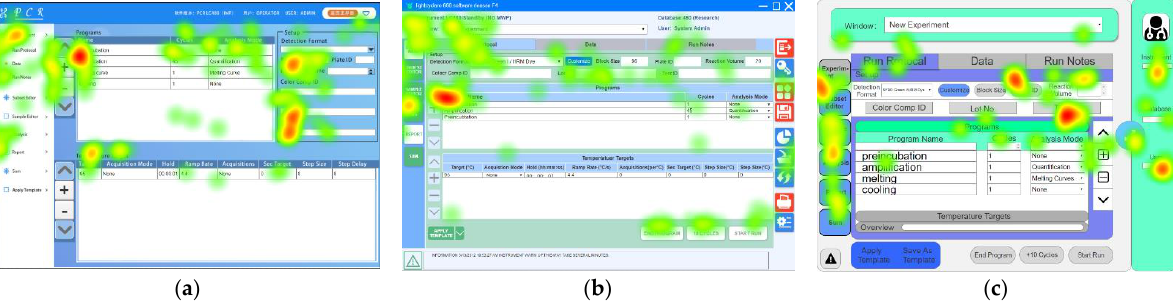
Figure 9. Weights of CPCs based on the results of Moran’s I analysis.